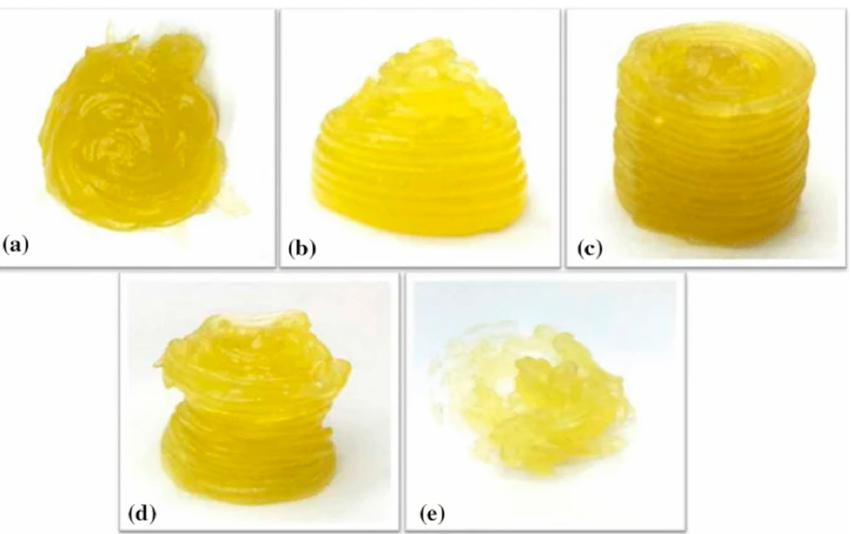
Figure 7. Various structural designs of 3D-printed lemon juice gel product at varying potato starch percentages: ( a ) 10%, ( b ) 12.5%, ( c ) 15%, ( d ) 17.5%, ( e ) 20%. Picture taken from an article by Waghmare et al. [37].